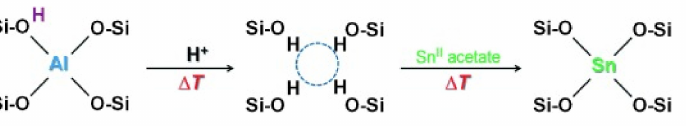
Figure 5. Schematic representation of the synthesis of Sn-Beta by the solid-state ion (SSI) exchange method. Reproduced with permission from [28]. Copyright 2012, Wiley-VCHH.